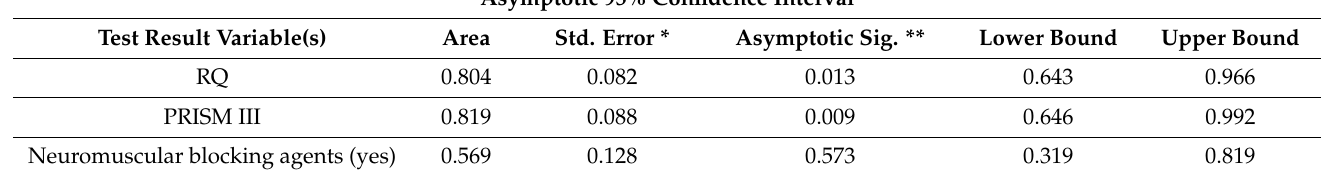
Table 5. Area Under the Curve for variables predicting REE VCO2 RQ 0.89 inaccuracy by overestimating REE IC for more than +10%.